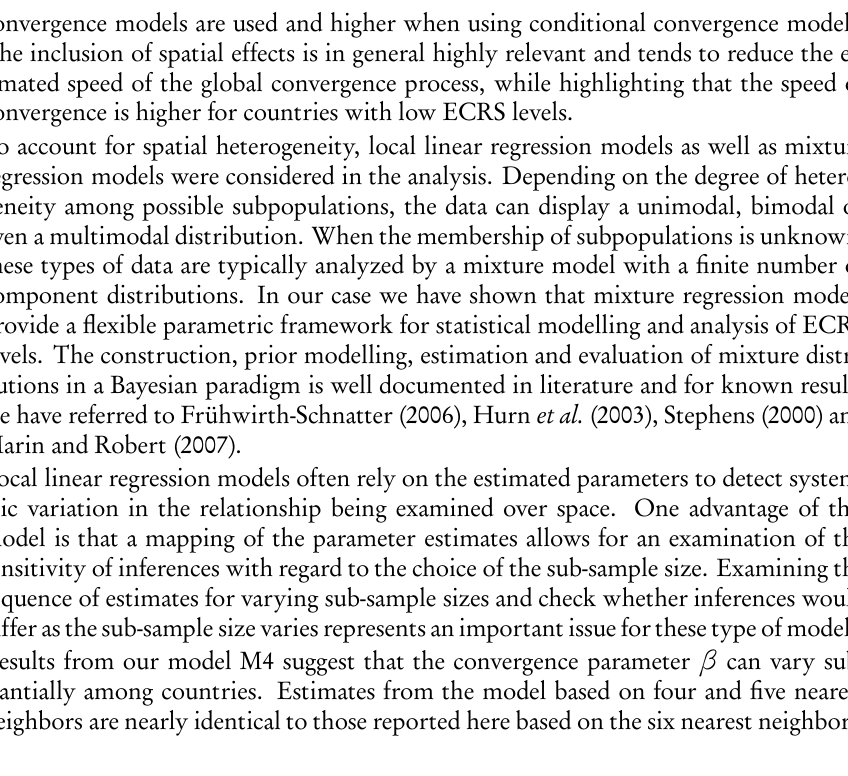
convergence models are used and higher when using conditional convergence